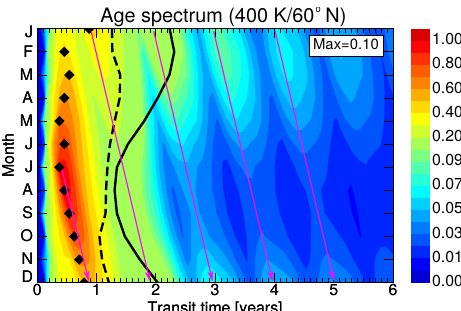
Figure 6. Seasonal cycle of the climatological age spectrum at 400K in the NH extratropics (60 ◦ N). Mean age is shown as black thick line, modal age as black symbols, and RCTT as black dashed line. The pink arrows illustrate the time evolution of the spectrum peaks. (Note the non-linear colour